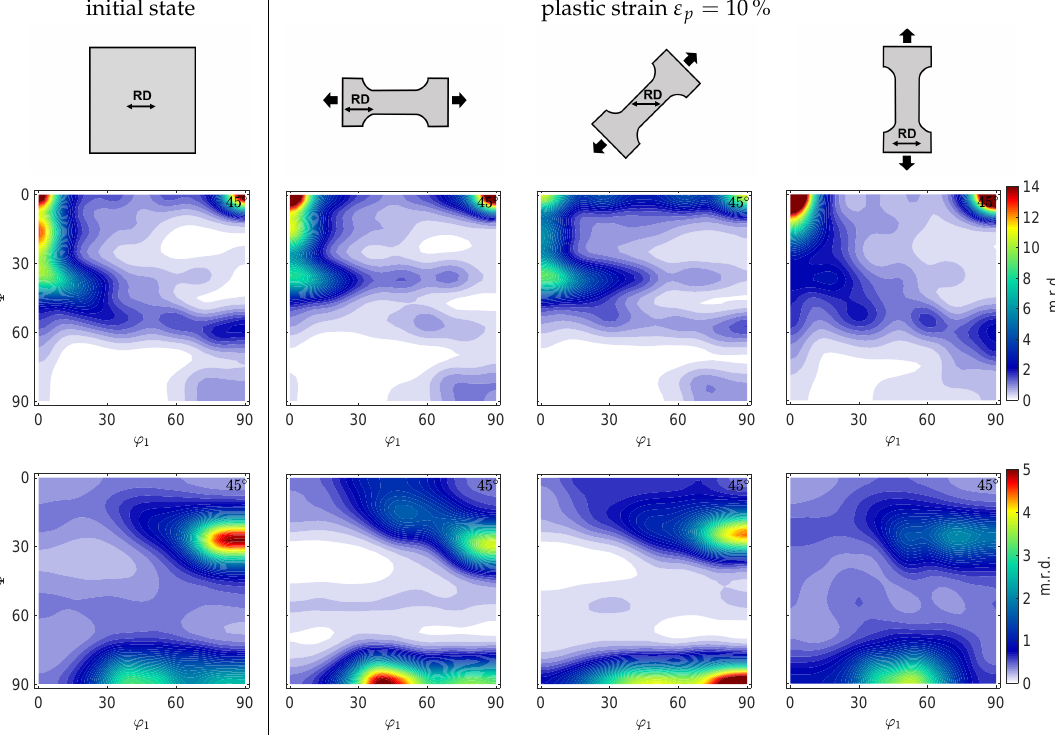
Figure 6. ODF sections ϕ 2 = 45 ◦ for initial state and after applied plastic strain of ε p = 10% in different orientations for ferrite phase ( top ) and austenite phase ( bottom